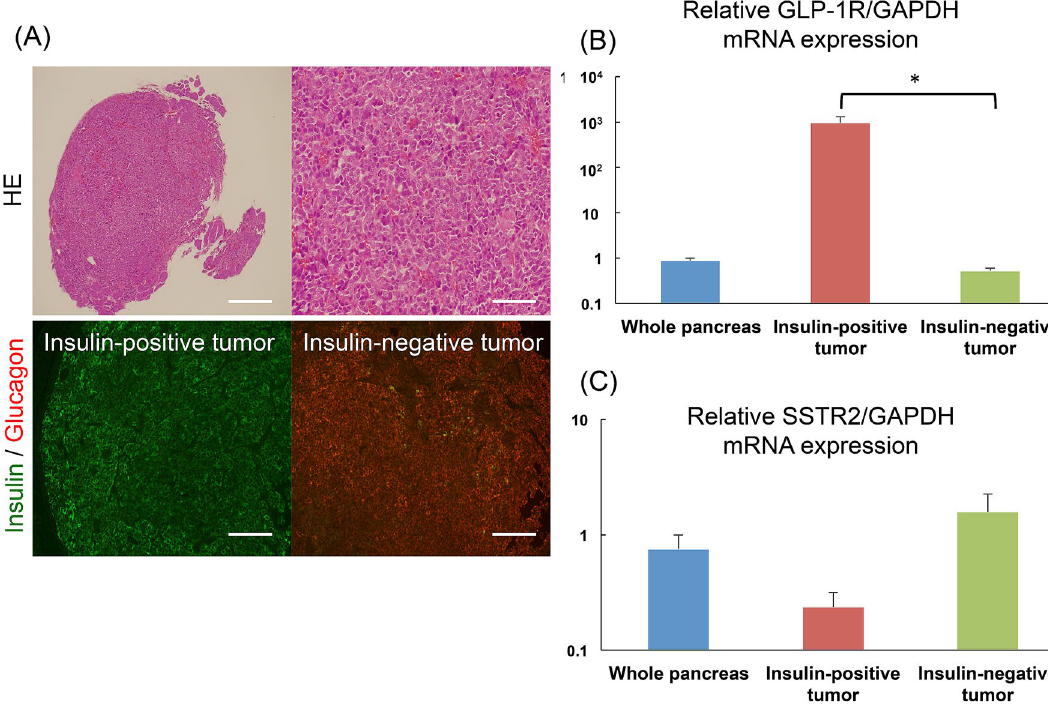
Figure 2. GLP-1R and SSTR2 mRNA expressions in pancreatic tumors of Pdx1-Cre;Trp53 R172H ;Rb f/f mice. Representative microscopic images of resected pancreatic tumors of Pdx1-Cre;Trp53 R172H ;Rb f/f mice are shown ( A ). Upper panels: Hematoxylin–Eosin (H&E), Scale bars indicate 500 μm in the left column and 200 μm in the right column, respectively; Lower panels: double immunofluorescent staining of insulin and glucagon. Insulin-positive tumor (left column) and insulin-negative tumor (right column). Scale bars indicate 200 μm. Relative GLP-1R ( B ) and SSTR subtype 2 (SSTR2) ( C ) mRNA expression levels of whole pancreas (n = 10), insulin-positive tumors (n = 6) and insulin-negative tumors (n = 6) are shown. The data are expressed as the mean ± SEM. *P <